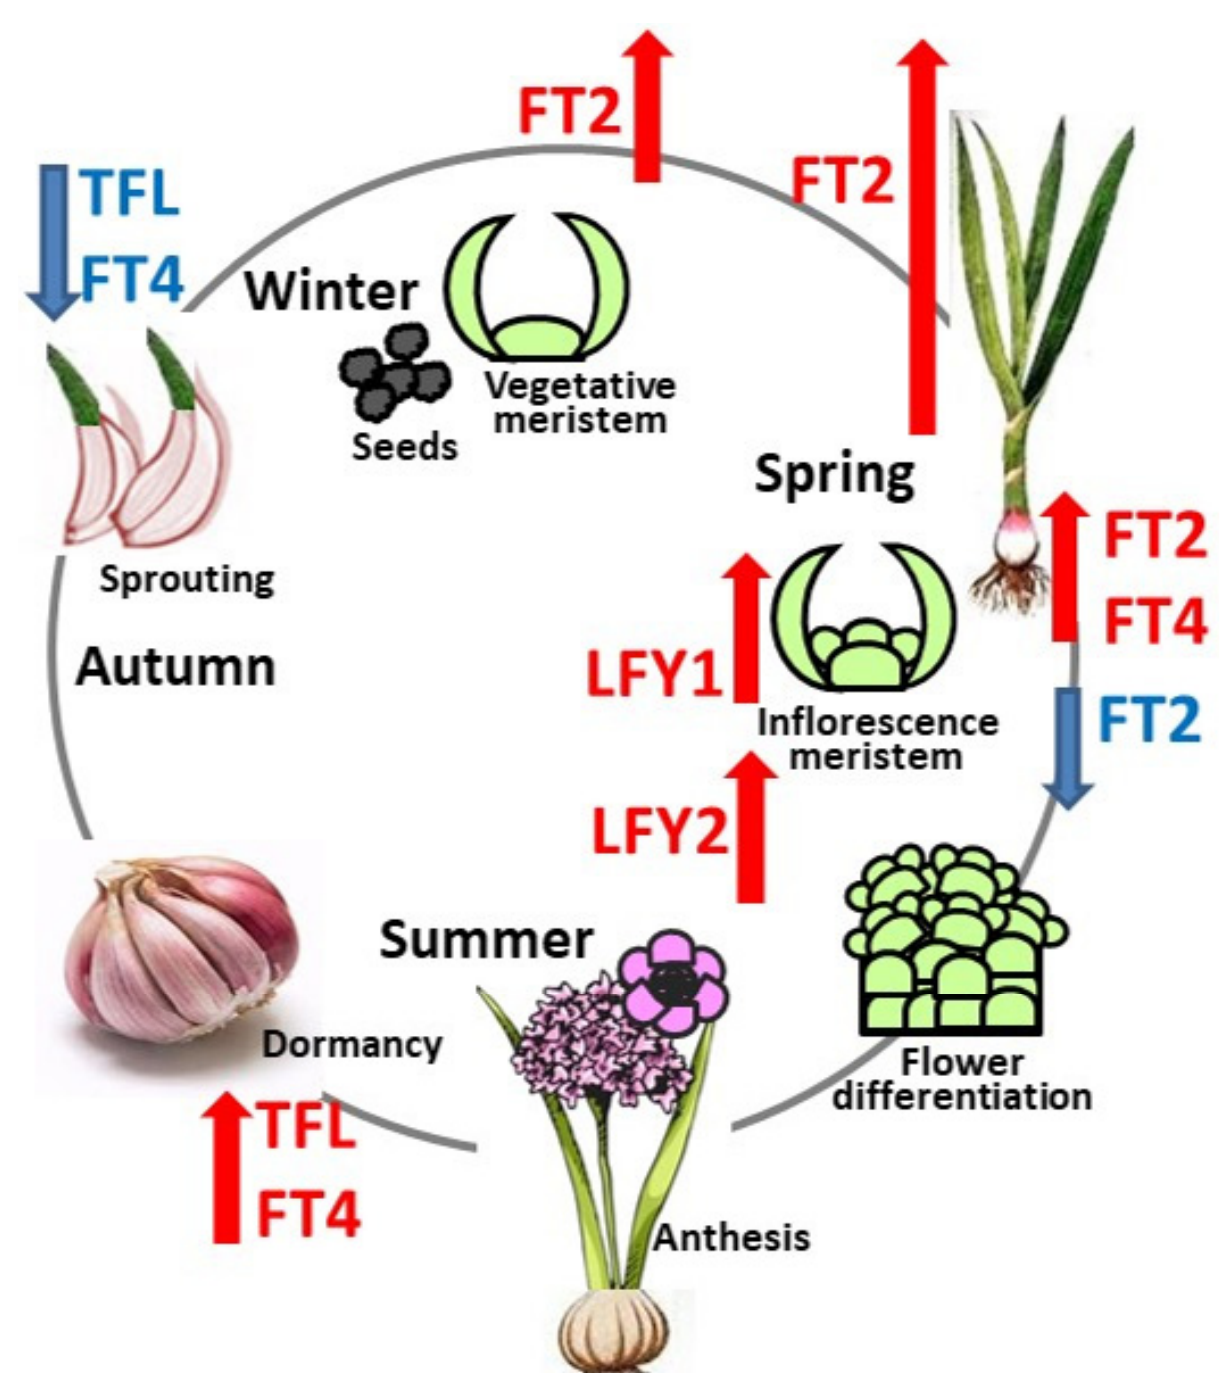
Figure 4. The life cycle of flowering and seed-producing garlic genotype is regulated by PEBP and LFY -like genes. Red and blue arrows indicate gene up-regulation and down-regulation, respectively. In summer, dormant meristems express AsTFL1 , which prevents floral induction, and AsFT4.4 , which might be involved in bulbing and dormancy. Following winter vernalization, AsTFL1 and AsFT4.4 are downregulated, cloves sprout, and during this growth stage, the florigen AsFT2.2 is upregulated in cloves, basal plate, and leaves. After floral induction, AsLFY1 acts in the apical meristem and in the developing inflorescence, while AsLFY2 is only expressed during organ differentiation in the individual flowers. After the floral transition, high expression of AsFT4.4 in the basal plate supports induction of the developing axillary meristems and